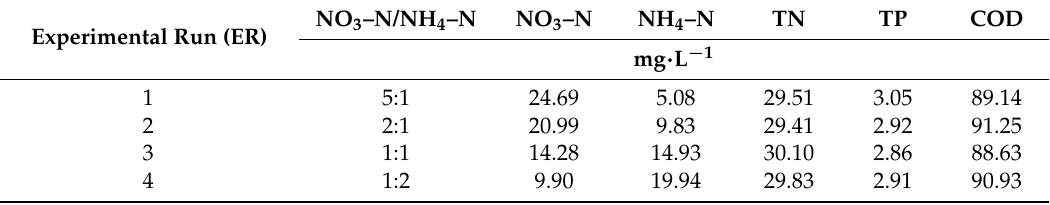
Table 2. Average influent stimulated wastewater quality of during experimental runs.